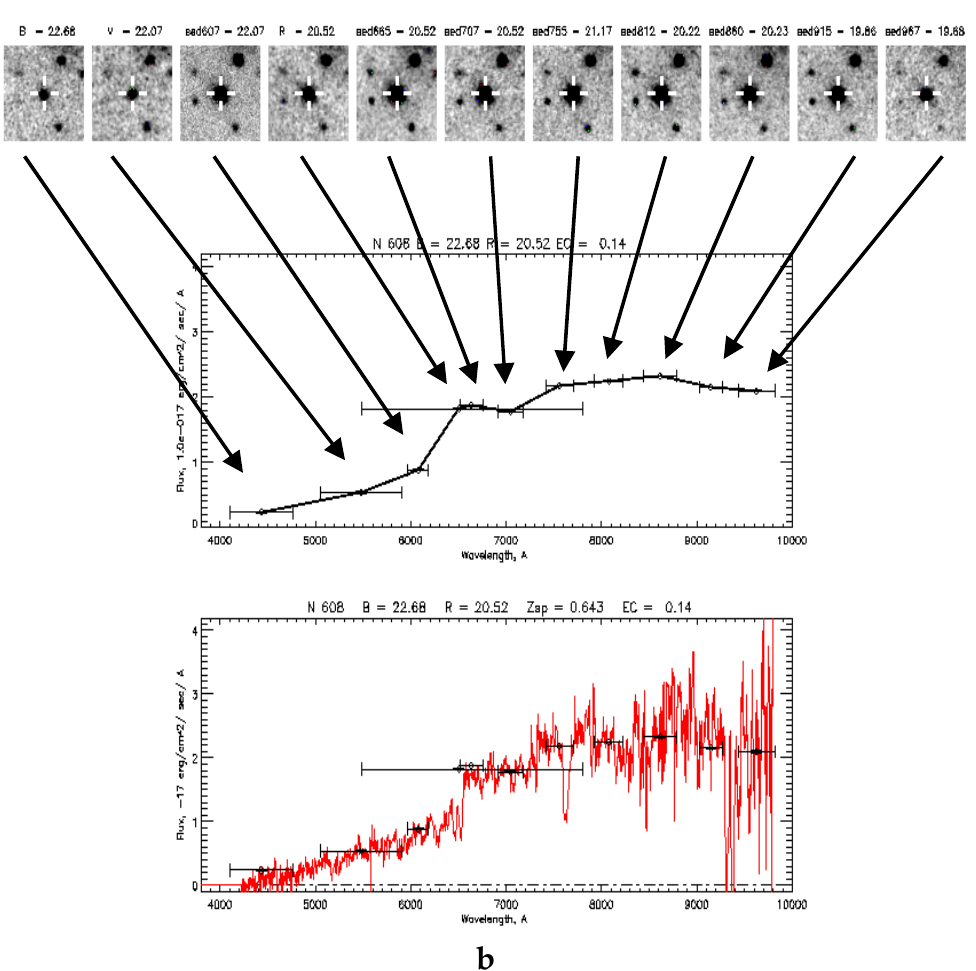
Figure 7. ( a ) Photometry algorithm scheme and ( b ) scheme of SED construction based on medium- data band data [9].